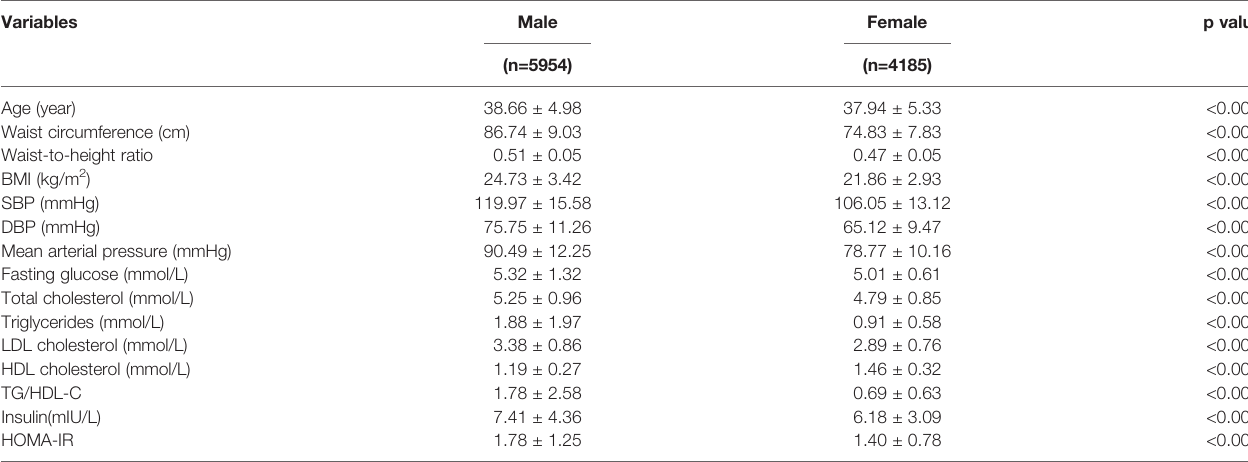
TABLE 1 | Basic characteristics of the study subjects.